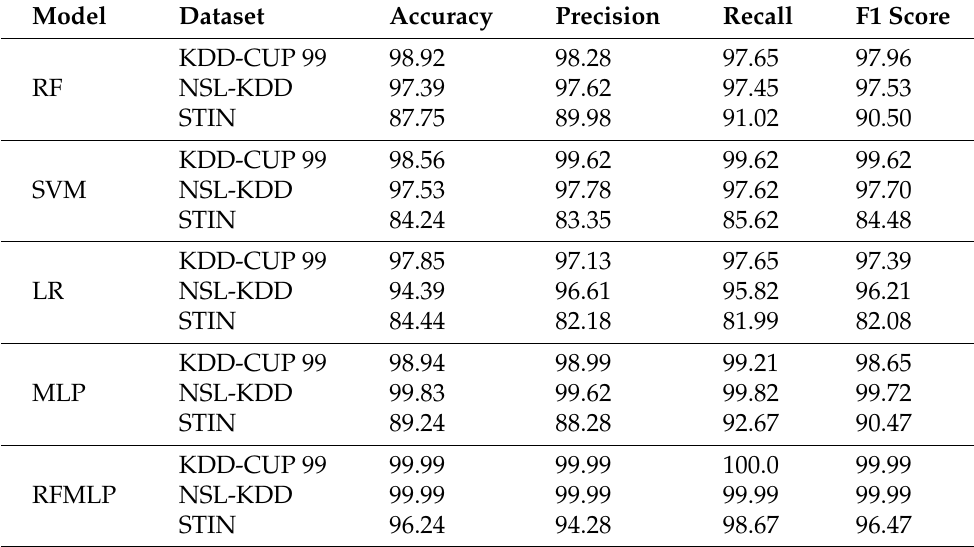
Table 9. Average Accuracy of classifiers on all three